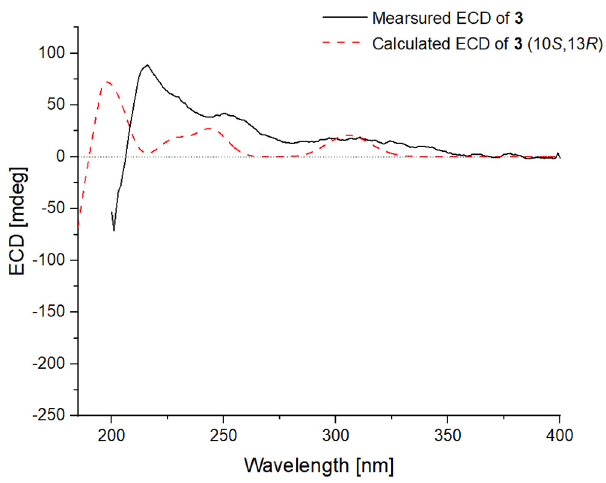
Figure 6. Experimental ECD spectrum of 3 (black line) comparing with that calculated for (10 S ,13 R ) − isomer of 3 at BH&HLYP/TZVP level (red dashed line).